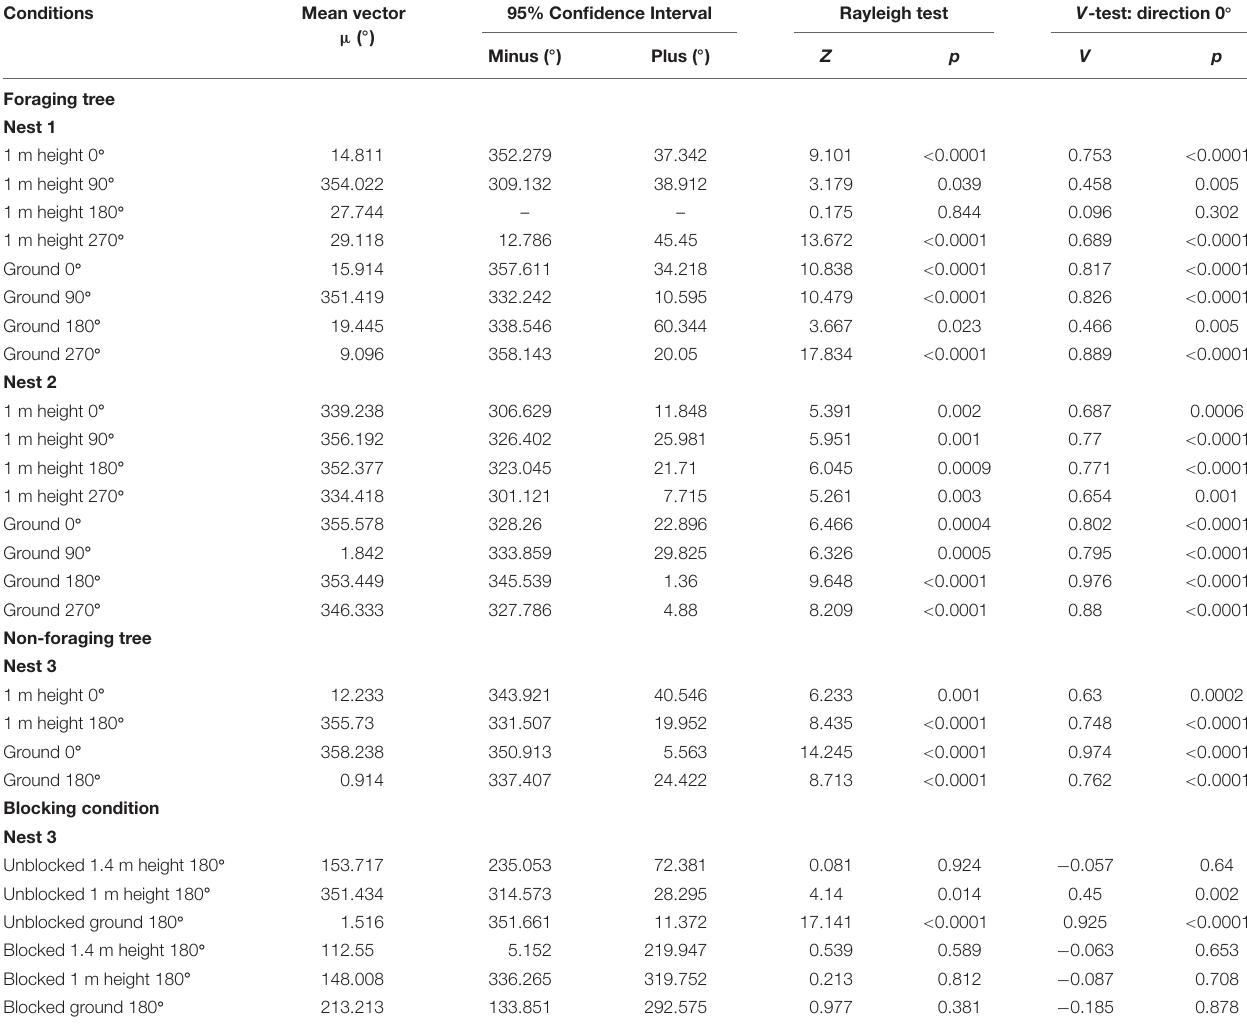
TABLE 1 | Statistical results for all on tree displacement